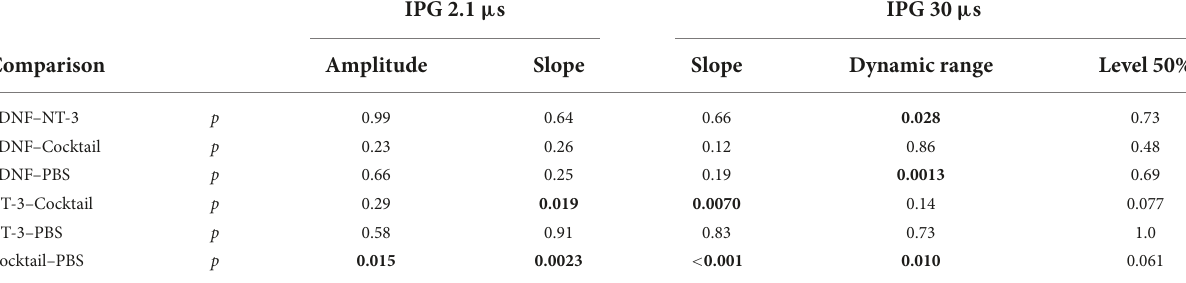
TABLE 5 P -values from the post hoc Tukey’s HSD, following the ANOVA on the eCAP measures for both